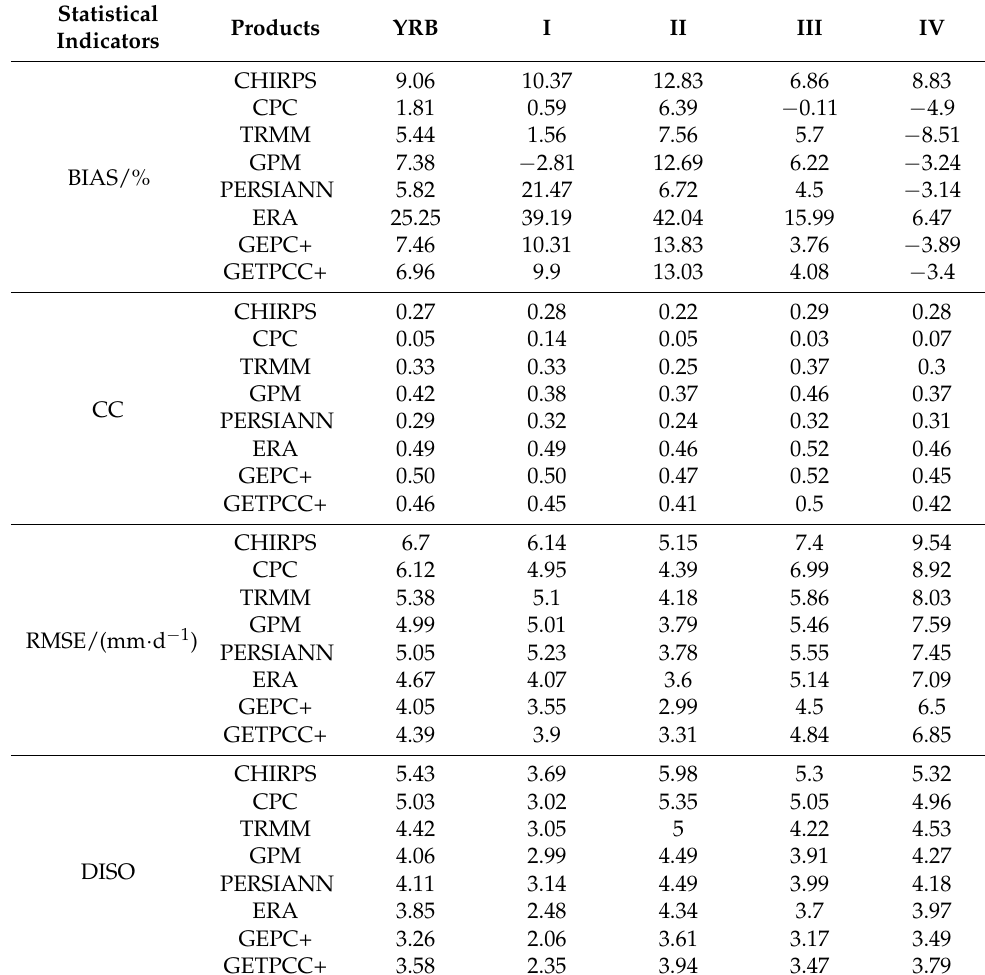
Table 2. Comparison and evaluation of daily observations and simulations. BIAS, CC, RMSE, and DISO are the regional averages of all verification